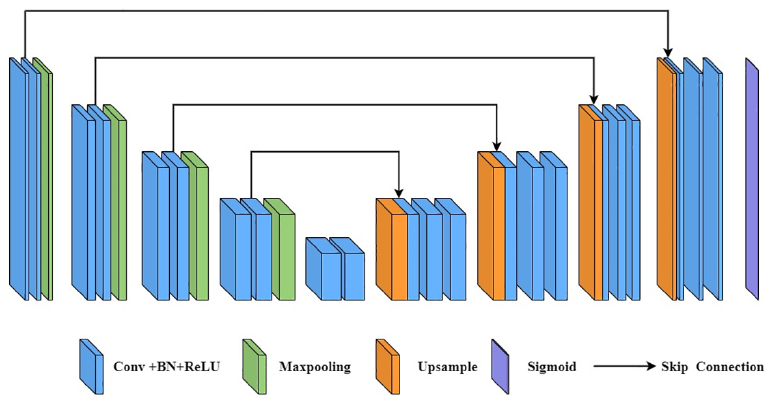
Figure 1. Structure diagram of U-Net model; consists of downsampling and